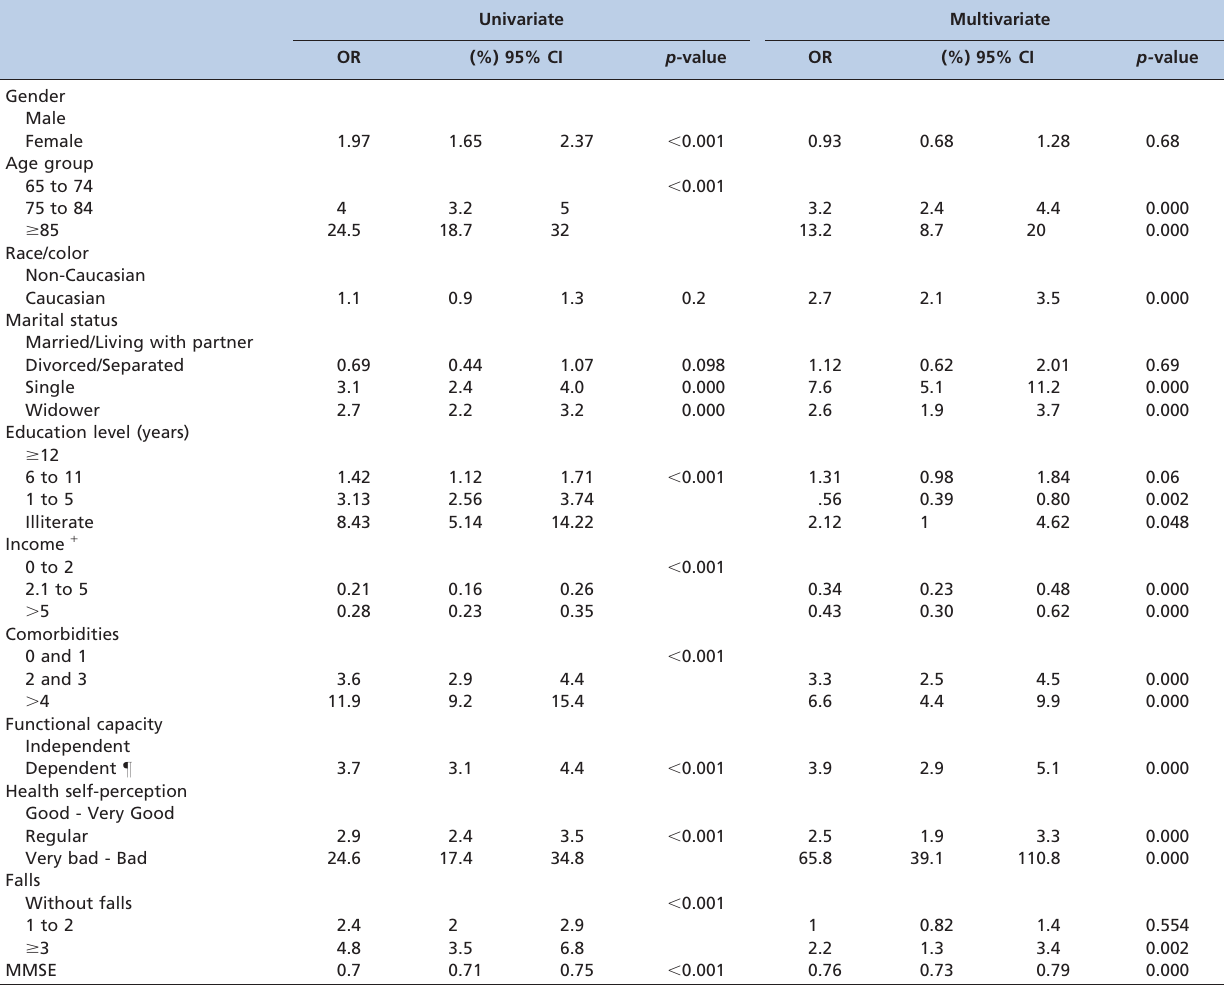
Table 4 - Univariate and multivariate logistic regression for the FS-CHS and the associated variables among individuals aged 65 years or older who were inhabitants of the northern region of Rio de Janeiro, Brazil in 2010 (n=